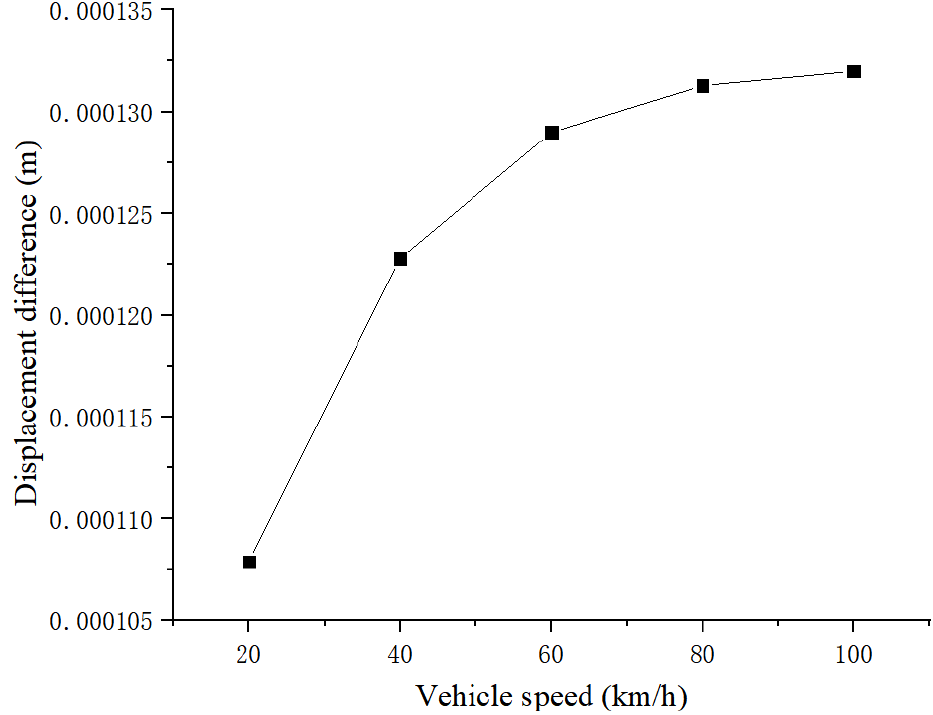
Figure 22. Variation of displacement difference at 14.625 m under different vehicle speeds.